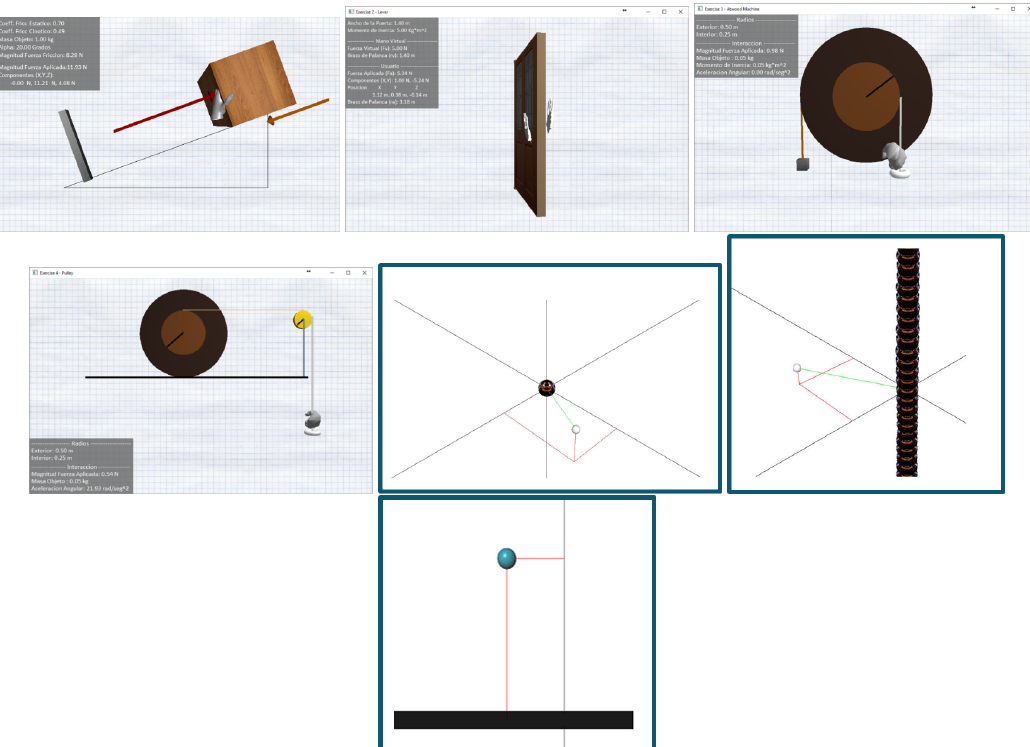
Figure 17. Previous developed simulators using traditional frameworks